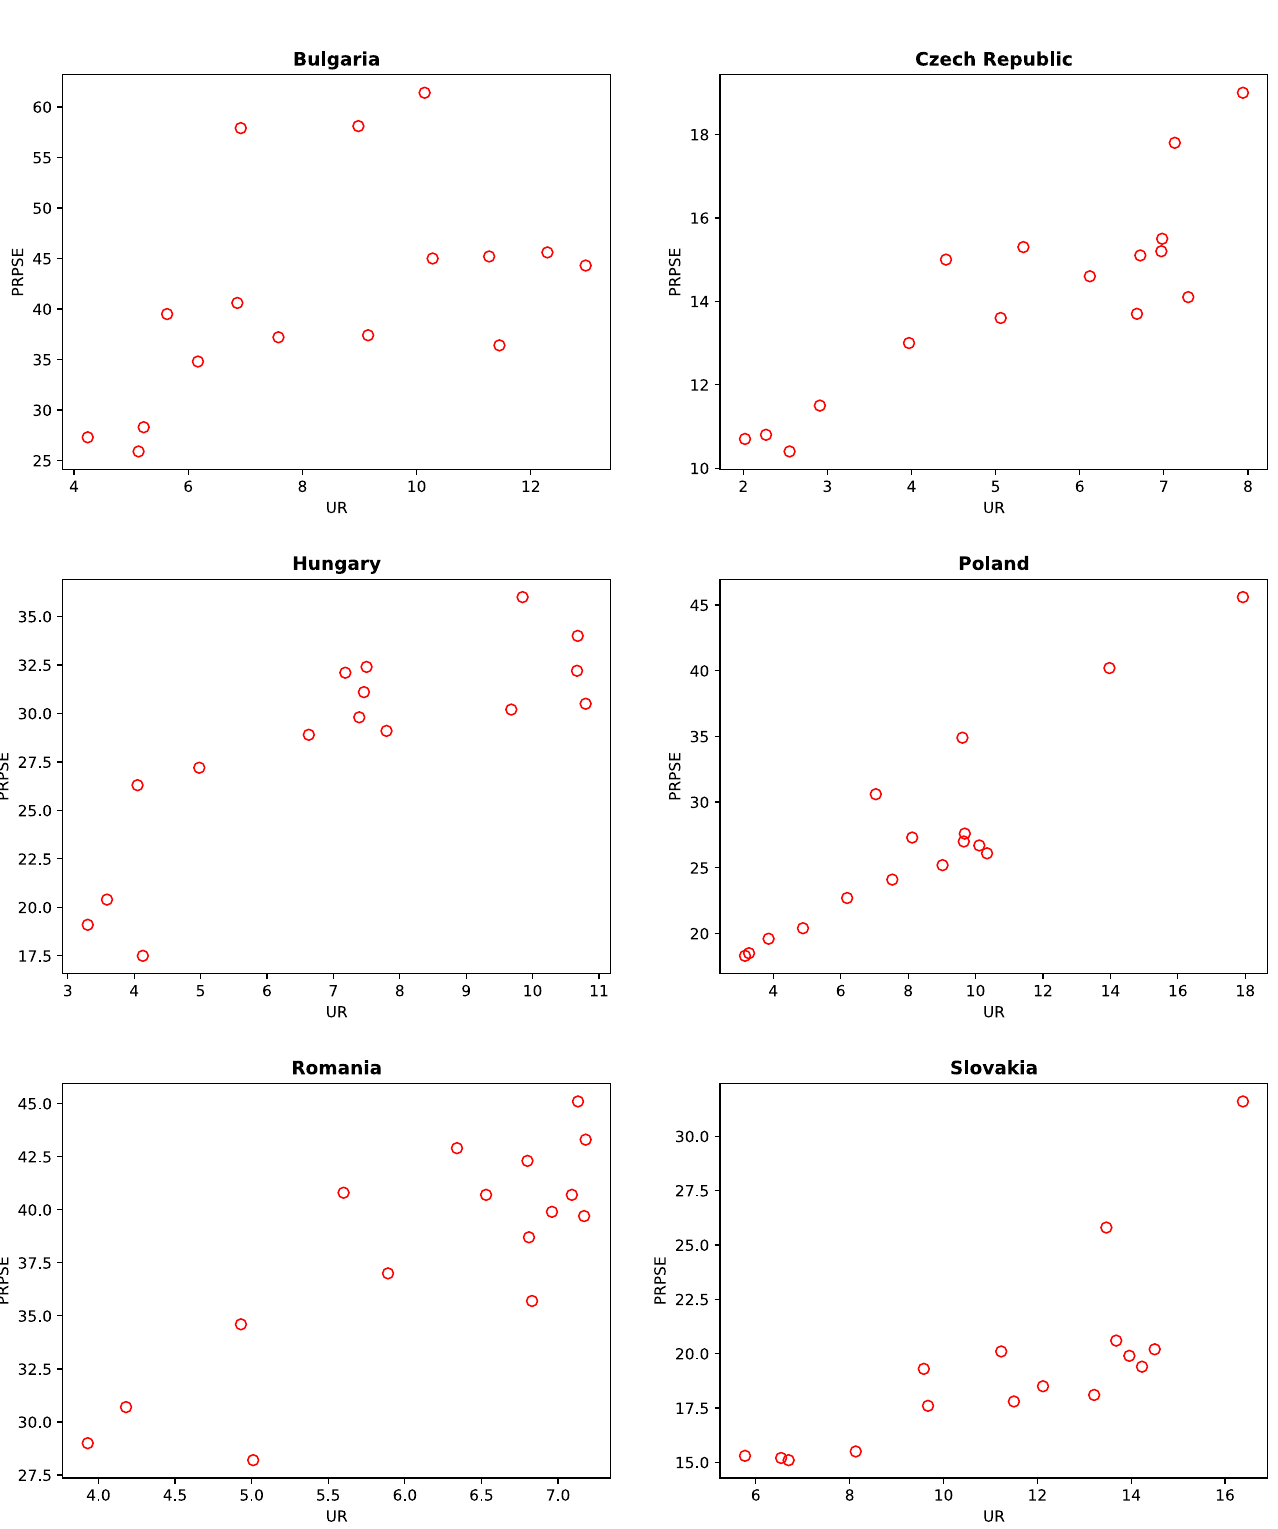
Figure 9. Scatter plot of PRPSE (percentage) on unemployment rate (percentage). Computing the Pearson correlation coefficient on the three variables (UR, PRPSE and SPLS) for every studied country (detailed in Table 3), we noticed a very strong positive correlation between UR and PRPSE (the correlation coefficient takes values from +0.501 to +0.921, except for Bulgaria, the rest of the values are above +0.765 at a significance